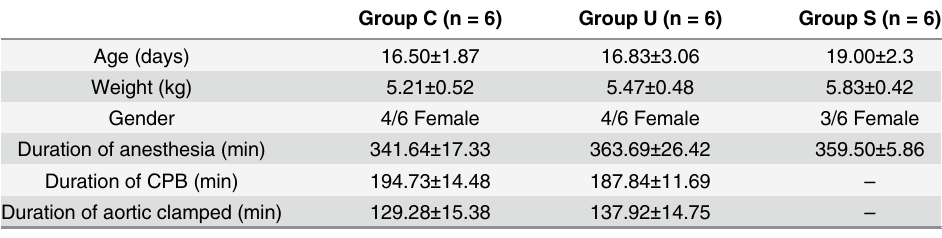
Duration of aortic clamped (min) Data are shown as mean ±